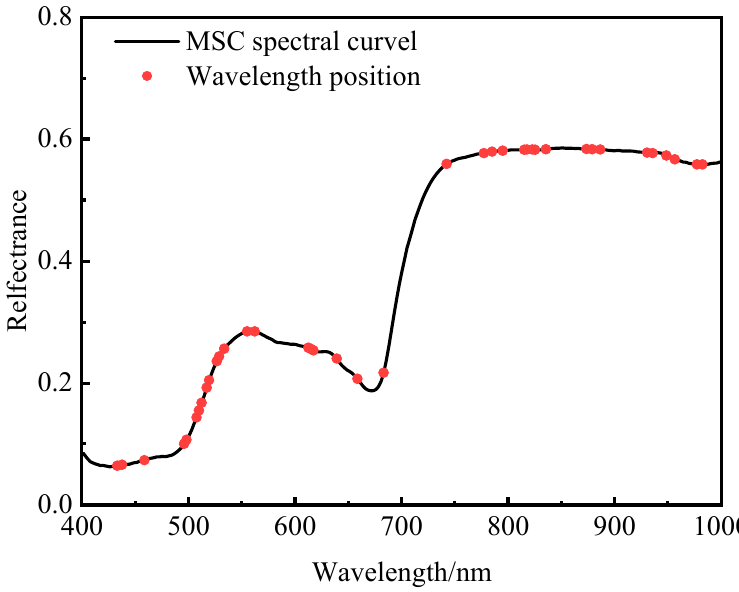
Figure 13. Characteristic wavelengths of the MSC spectral curve selected using the CARS algorithm. Table 4. The results of GA, PLS-DA, LSVM, and BP classification based on characteristic